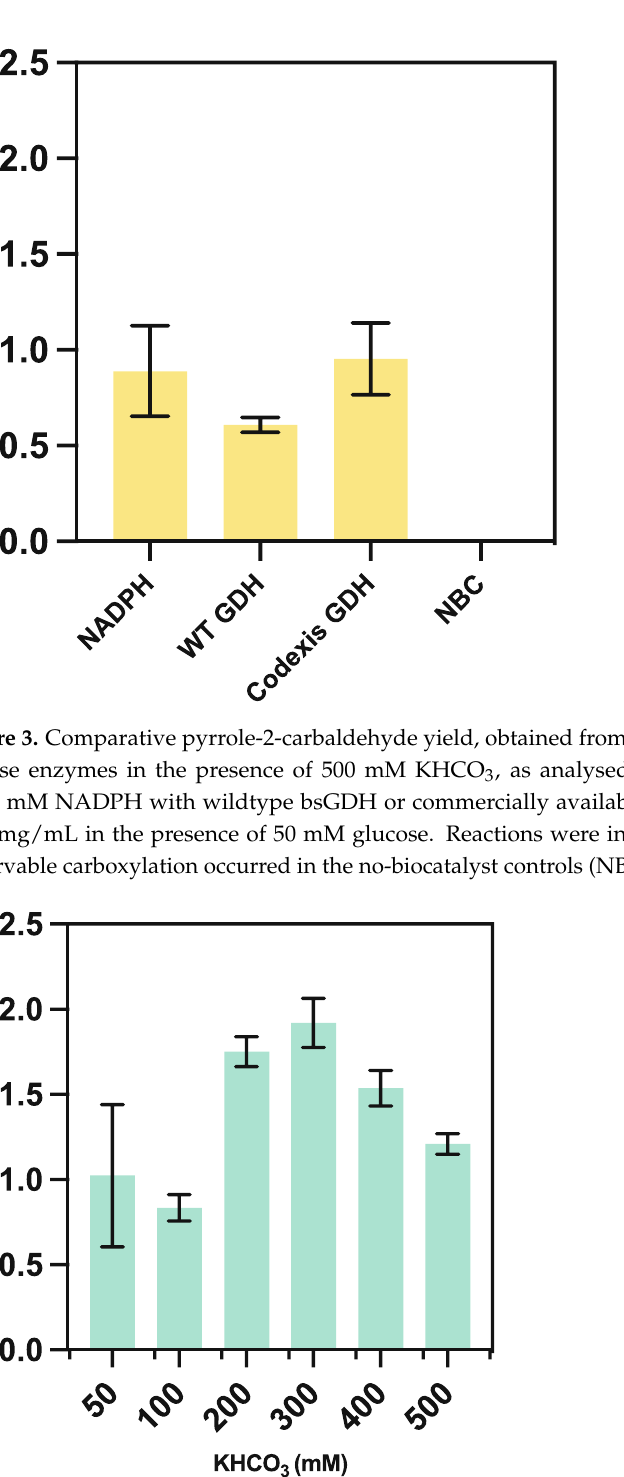
Figure 4. Effect of bicarbonate salt concentration on yield of pyrrole-2-carbaldehyde from 10mM pyrrole, at conditions ranging between 50 – 500 mM KHCO 3 utilising purified PA0254 and CARse biocatalysts. No carboxylation of pyrrole was observed in controls lacking biocatalyst at any concentration of bicarbonate.